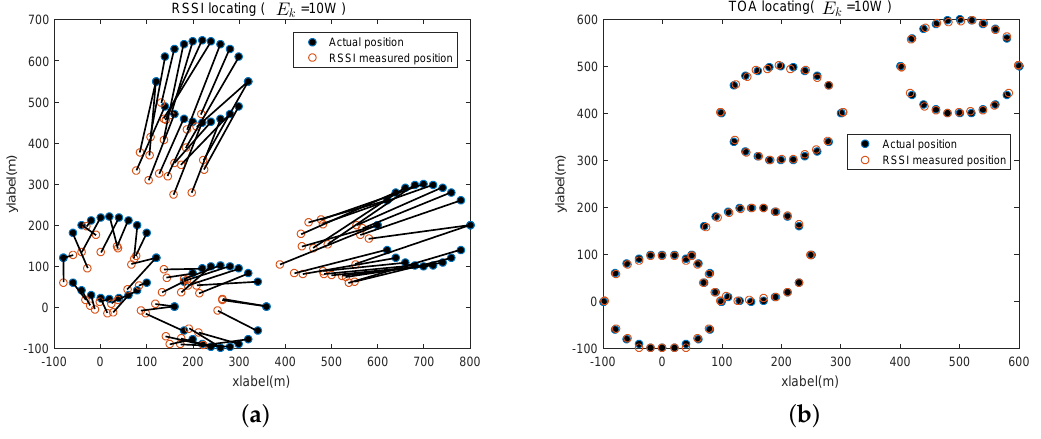
Figure 7. Accuracy comparison of TOA and RSS-based SUE positioning. ( a ) Accuracy of received signal strength (RSS)-based secondary user equipment (SUE) positioning. ( b ) Accuracy of time of arrival (TOA)-based SUE